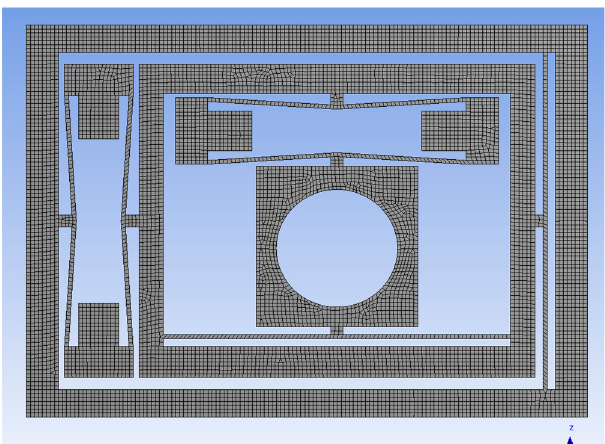
Figure 11. The mesh of micro-positioning platform.